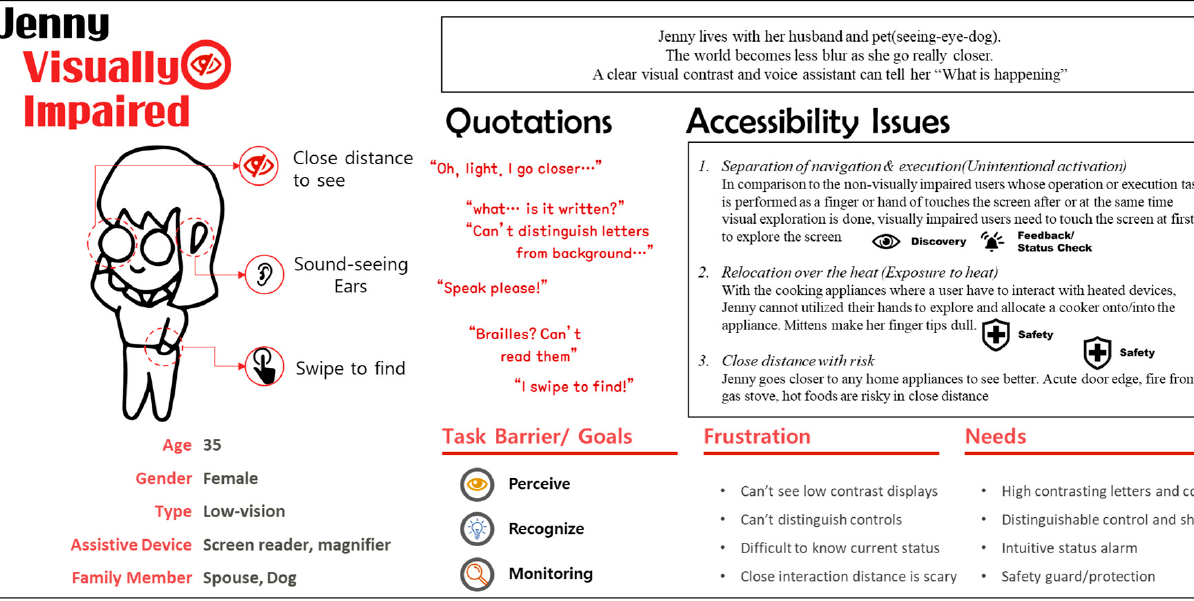
Figure A2. Persona card of Jenny, the low-vision